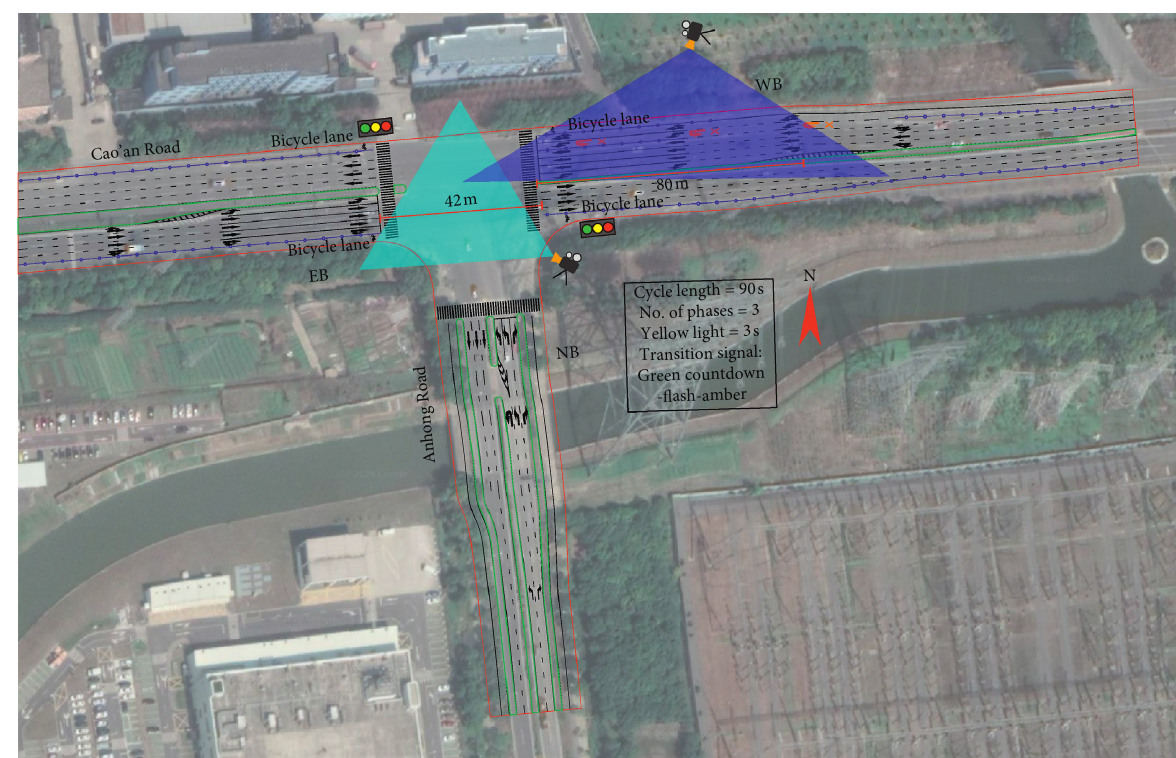
Figure 2: Camera setting and data collection at the study intersections.